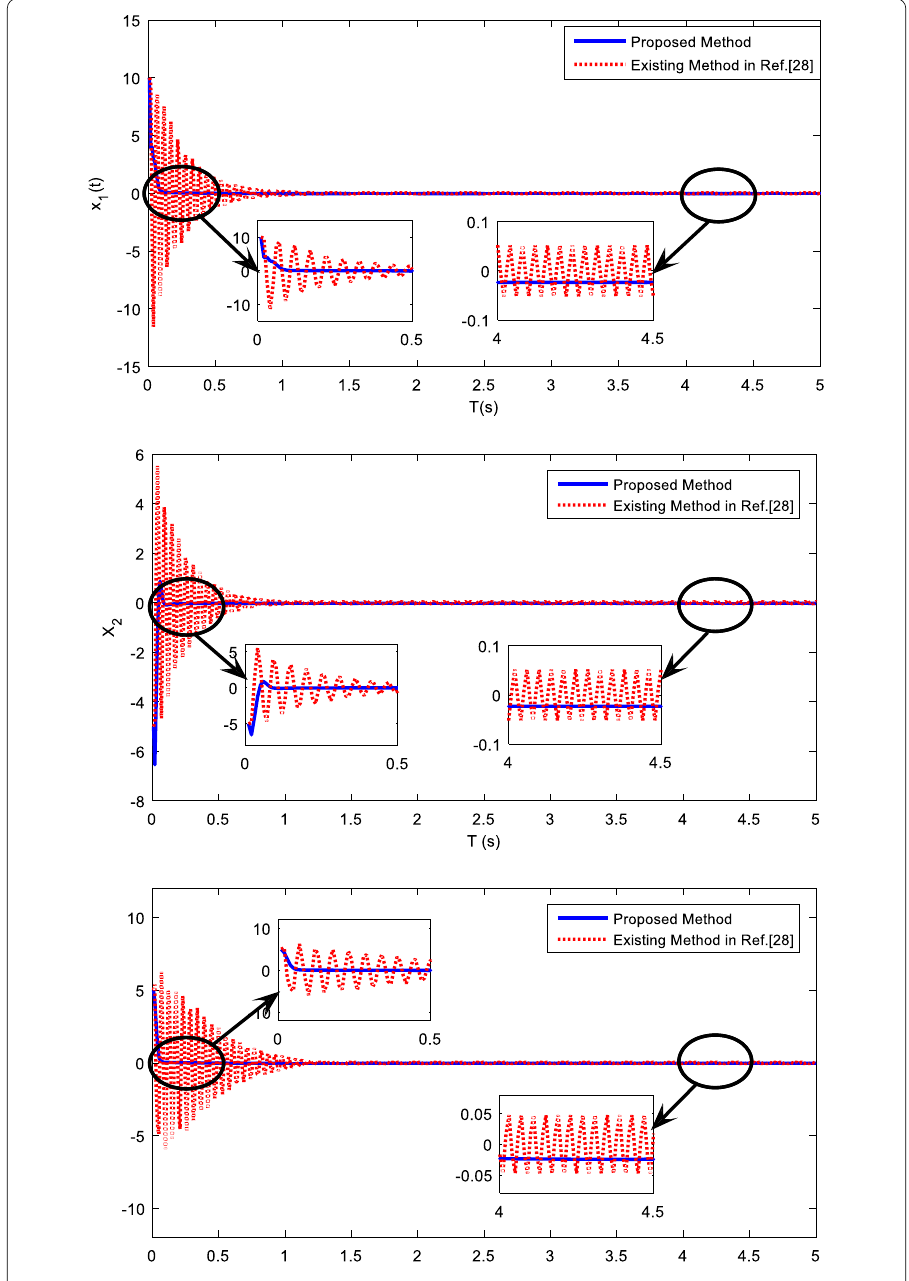
Figure 7 Comparison of the proposed FISMC method with the method in Ref.